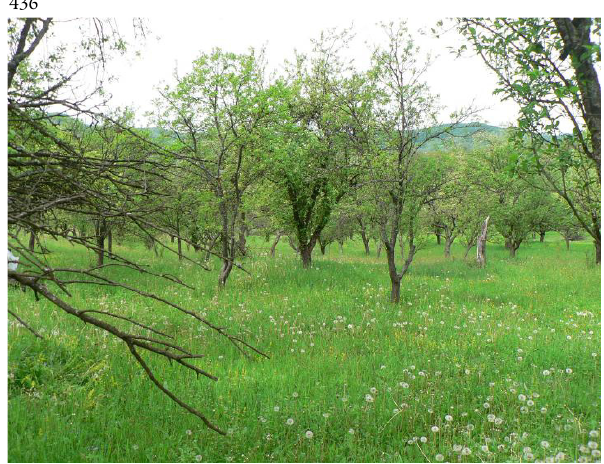
Fig. 2. General aspect from the investigated